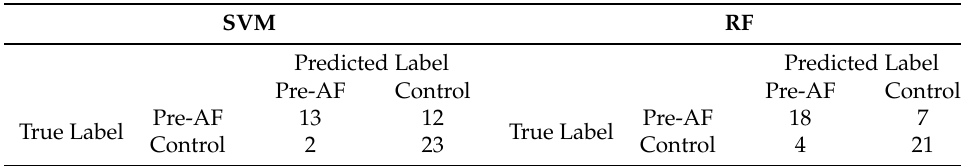
Table 7. Confusion matrix on the test data (7.5 min before onset).